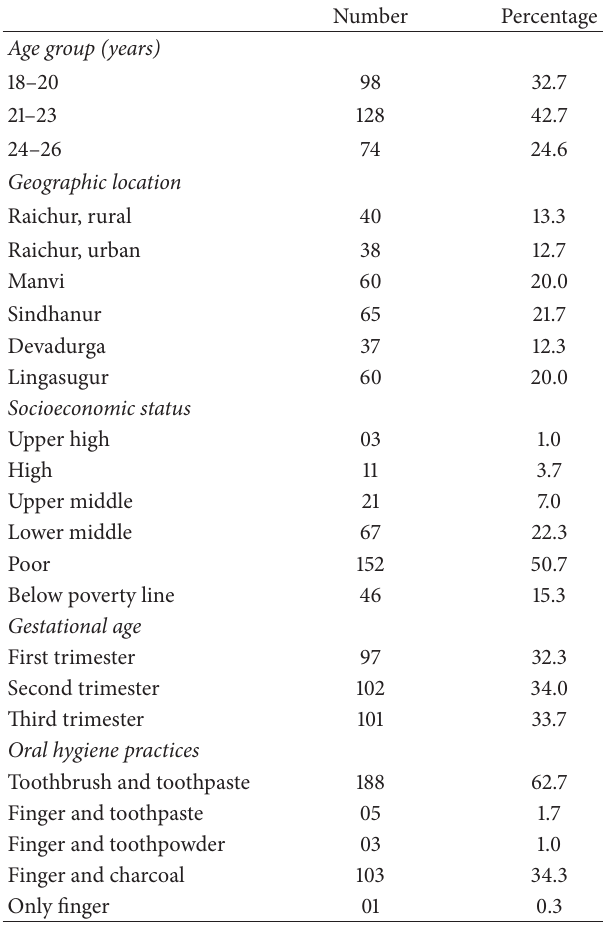
Table 1: Sociodemographic characteristics of 300 pregnant